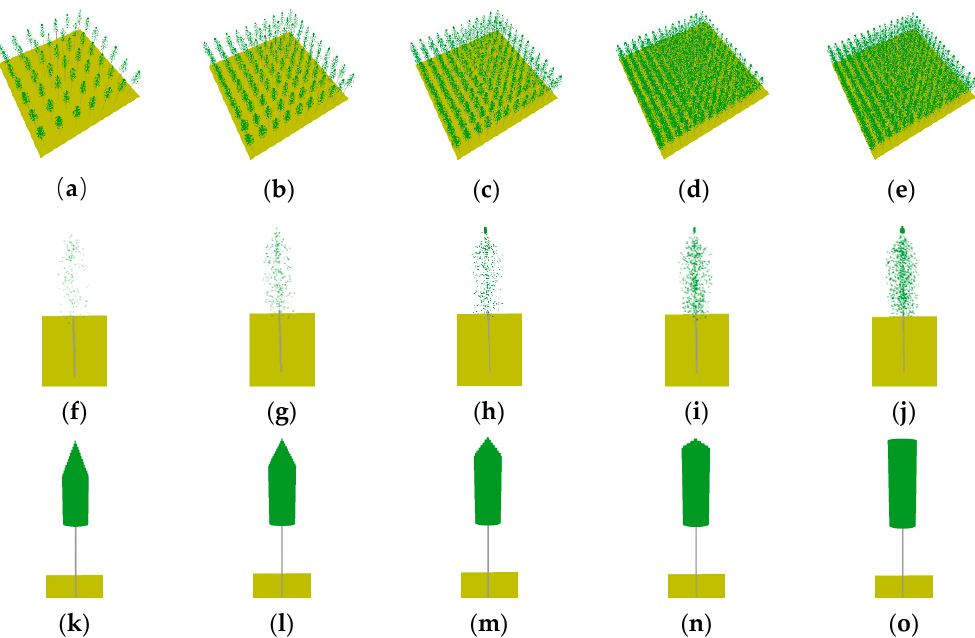
Figure 10. Virtual scenes for sensitivity analysis on penetration depth: ( a – e ) with a stem density of 200, 400, 600, 800, 1000 stems / ha when single tree LAI was 3.0 and crown ratio of cylinder part was 70%; ( f – j ) with a single tree LAI of 1.0, 2.0, 3.0, 5.0, 7.0 when stem density was 500 stems / ha and crown ratio of cylinder part was 70%; ( k – o ) with a crown ratio of cylinder part of 60%, 70%, 80%, 90%, 100% when stem density was 500 stems / ha and single tree LAI was 7.0.